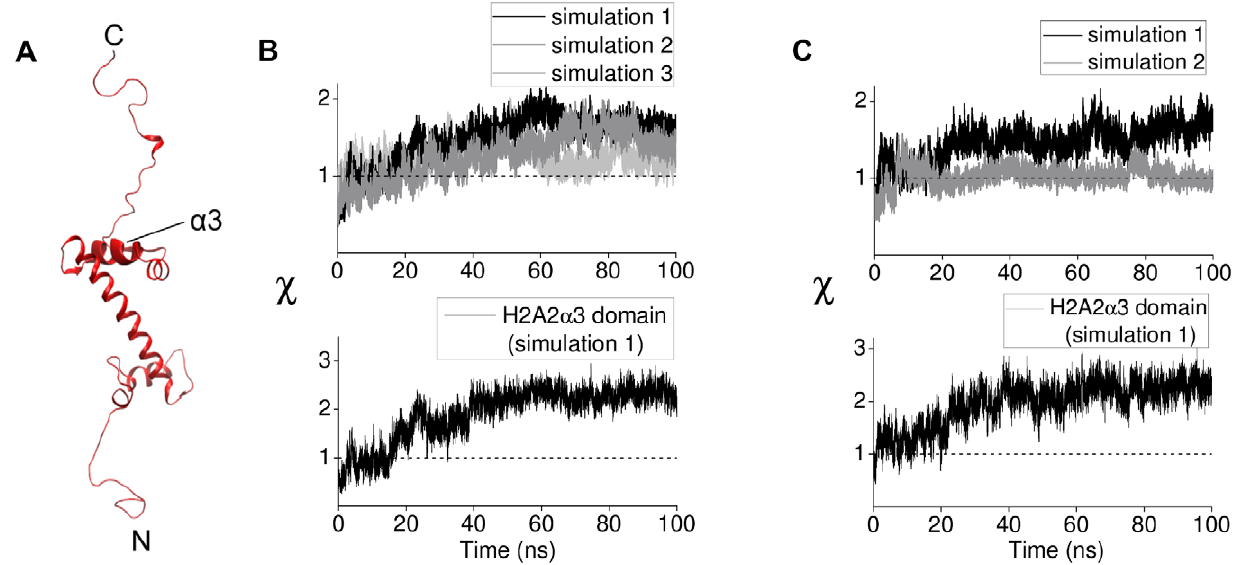
Figure 5. Structural changes in histone H2A(2) during tail-truncated simulations. (A) Structure of histone H2A with position of the a 3 domain shown by thickened helix. (B) Upper panel . Order parameter x for H2A(2) fold domain from three independent H3 tail-truncated nucleosome simulations. Lower panel . Order parameter x for H2A(2) a 3 domain from the H3 tail-truncated nucleosome simulation 1. (C) Upper panel . Order parameter x for H2A(2) fold domain from two independentH2Atail-truncatednucleosomesimulations. Lowerpanel .Orderparameter x forH2A(2) a 3